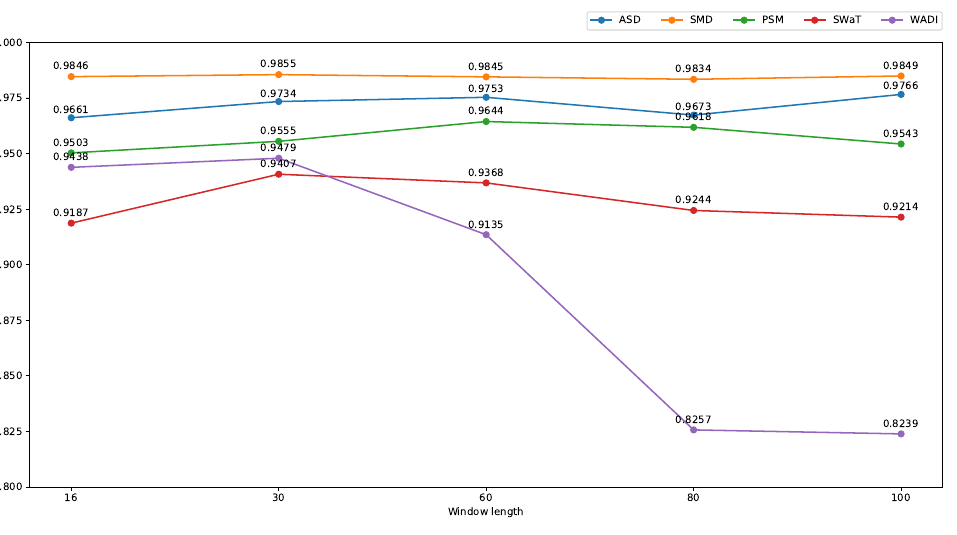
Figure 9. Model performance on different window lengths.